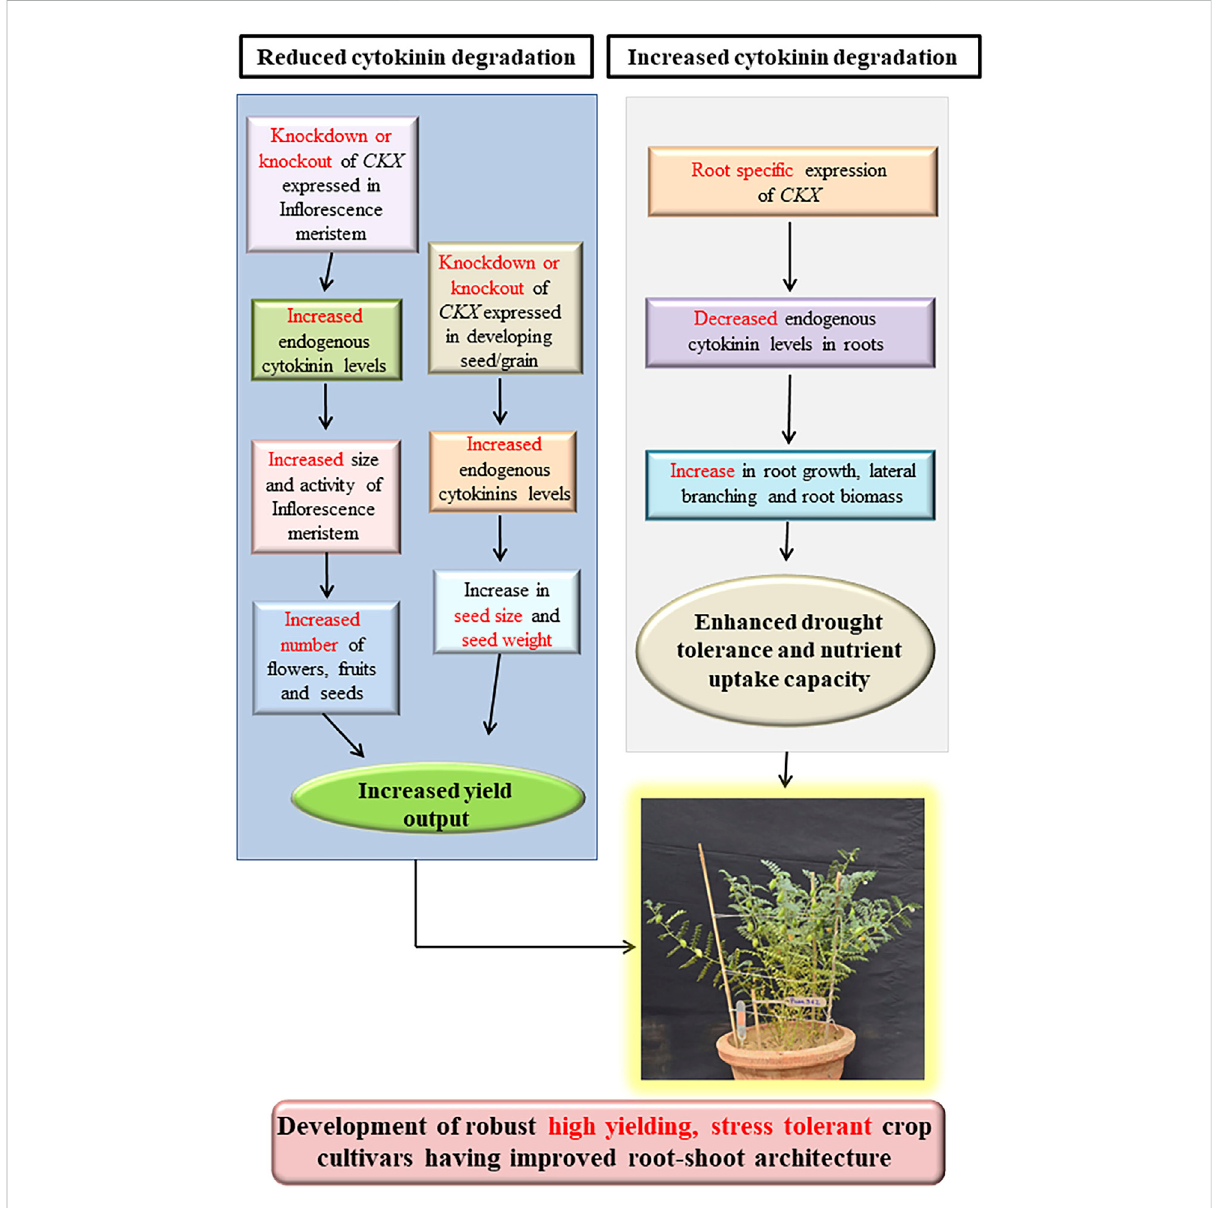
FIGURE 2 Combined strategy for the development of high yielding, bioforti fi ed, drought-tolerant crop cultivars through alteration of endogenous cytokinin by genetic manipulation of cytokinin oxidase/dehydrogenase family genes (Modi fi ed from (Jameson and Song, 2020b).